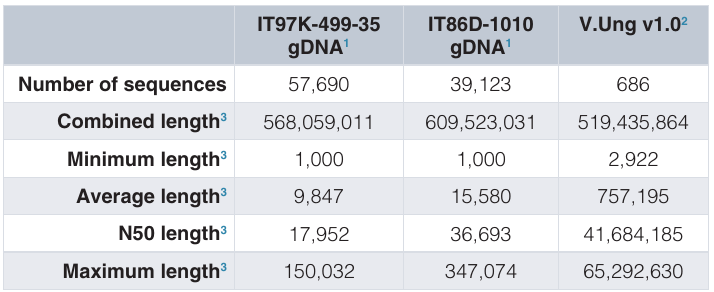
Table 1. Details of IT97K-499-35 and IT86D-1010 genomic DNA contigs generated and assembled in this study. Contigs of less than 1000 base pairs were excluded in this summary. Comparison to the V. unguiculata genome v1.0 of IT97K-499-35 is